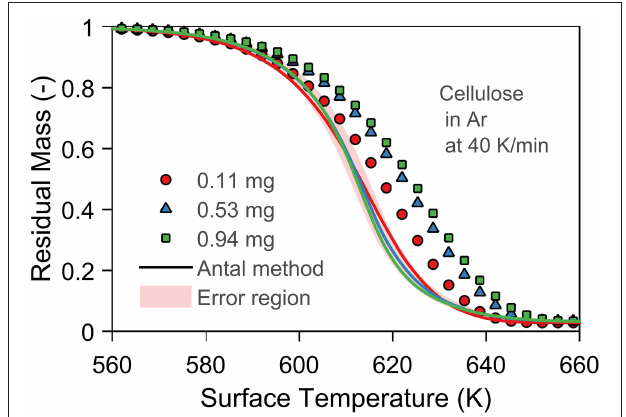
FIGURE 2 | Validation of the Antal method using model B and a kinetic model expressed in mass conversion. The experiments and corresponding kinetic model are taken from Grønli et al. (1999). The material properties and heat of pyrolysis from Narayan and Antal (1996) (same author and cellulose as in the shown experiments). The shadow area represents the random error (2K) in TGA. The symbols are the measurements by Grønli et al. (1999), and the lines are the corrected measurements using the Antal